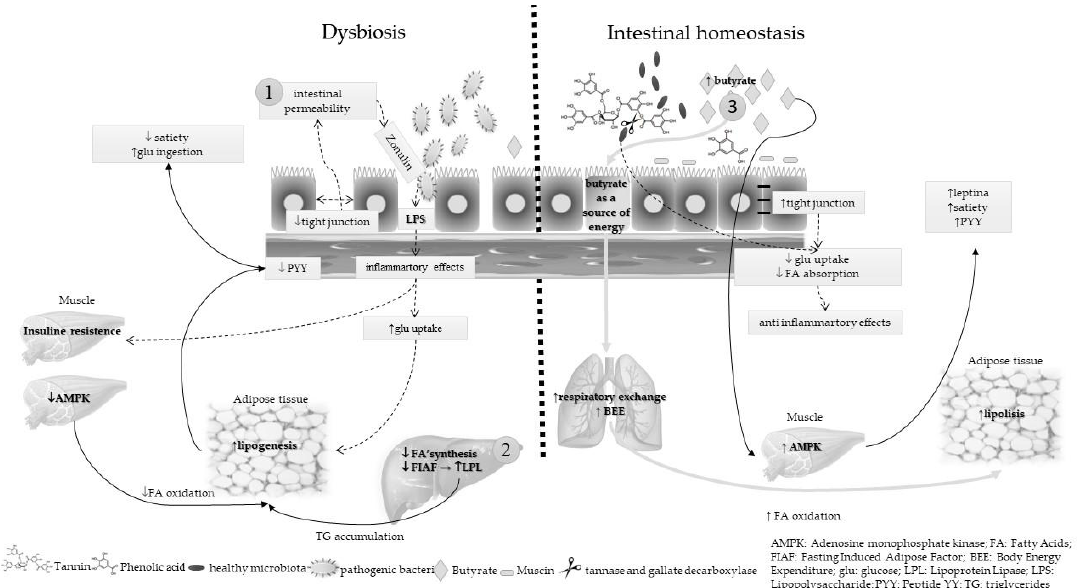
Figure 1. Energy metabolism modulation by microbiota: dysbiosis and intestinal homeostasis.